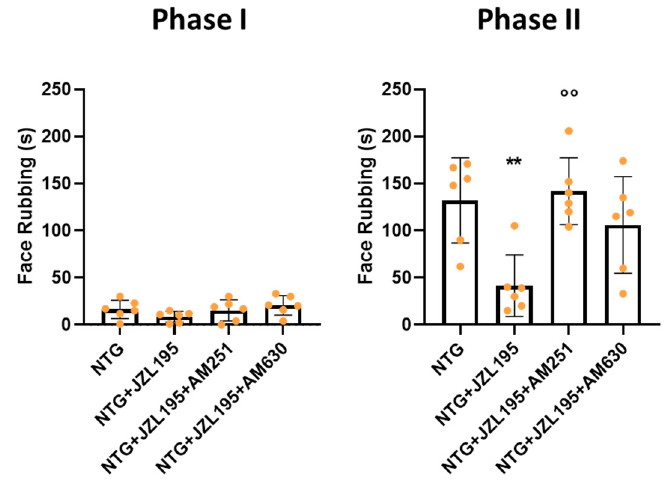
Figure 5. Phases I and II of the orofacial formalin test. Male Sprague–Dawley rats were treated with JZL195 (3 mg/kg) with or without the CBs antagonist (1 mg/kg) dissolved in a volume of 2 mL/kg